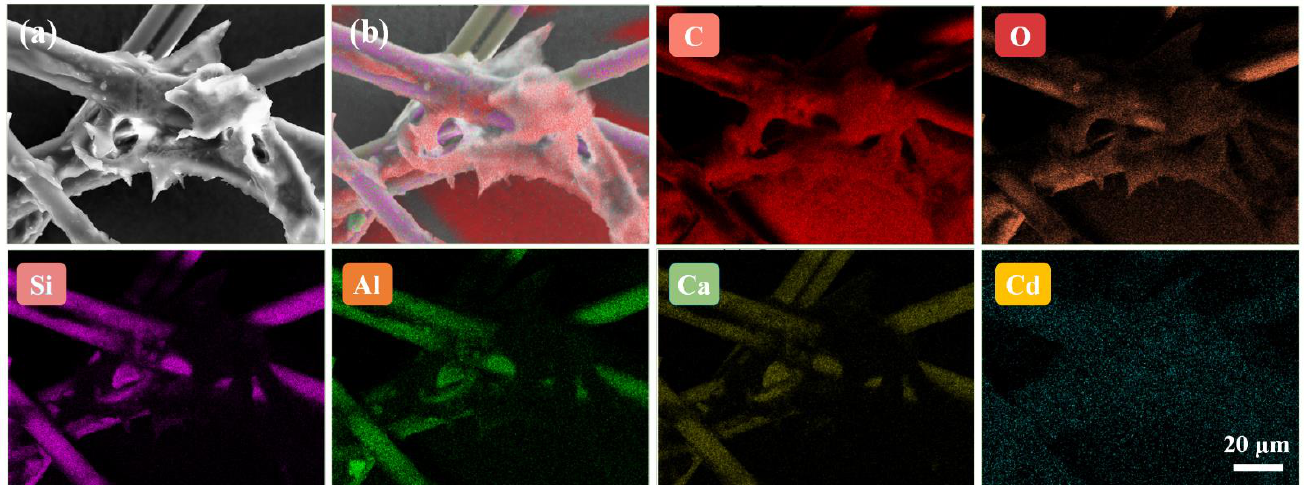
Figure 7. SEM image of the imprinted paper chip ( a ), composite EDS elemental mapping image of six elements ( b ) and corresponding EDS elemental mapping images of C, O, Si, Al, Ca and Cd in imprinted paper chip.